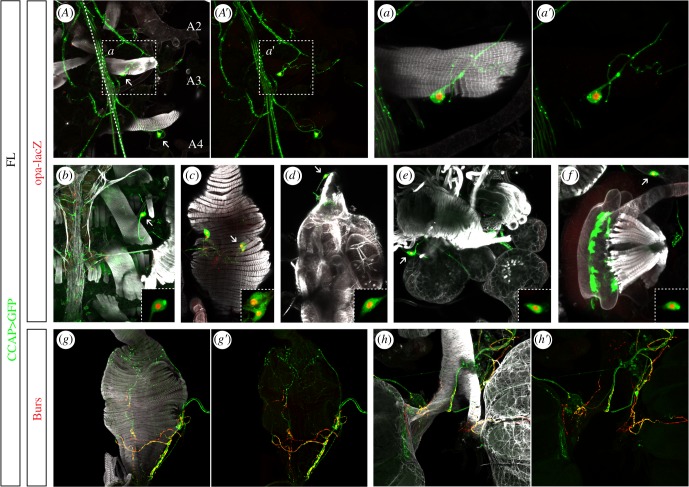
Expression of opa and Burs in adult peripheral CCAP neurons. (A–a′) CCAP neurons innervating the pleural internal transverse muscles (PITM); the adult muscles are inherited from the larva. The picture is taken at the level of the PITM at the A2/A3 and A3/A4 borders. Both PITM are associated with a CCAP cell body (arrows). (a) and (a′) are zoom from the marked square region in (A) and (A), respectively. The dashed line marks the ventral midline with the anterior towards the top. (b–h′) CCAP neurons innervating the aorta (b), the rectal ampulla (c,g,g′), the oviduct (d,h,h′), the spermatheca (e) and the ejaculatory bulb (f). All peripheral CCAP neurons expressed opa (b–f) and Burs (g–h′). The inserts in (b–f) correspond to CCAP cell bodies marked by arrows. Pictures have been taken from recently born adults. Phalloidin (FL) marks filamentous actin. All images are maximum projections of stacks except the inserts that correspond to a single section.